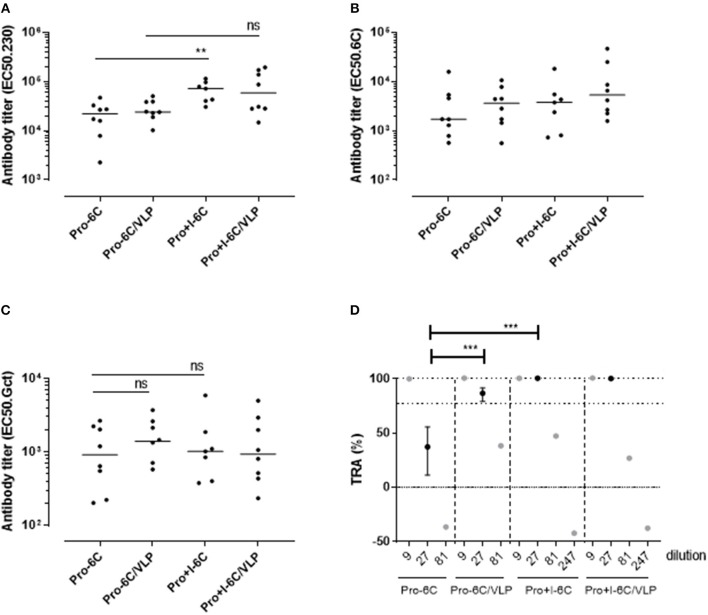
VLP-delivery of Pro-6C and Pro+I-6C. Groups of mice (n = 8) were immunized with soluble Pro-6C and Pro+I-6C or bound to AP205. Day 56 serum was tested for antibody reactivity on ELISA plates coated with (A)
Pfs230 Pro+I,II,III (B), Pfs48/45-6C or (C) gametocyte extract. Antibody titers (dots represents individual mice) are expressed as EC50 values. Horizontal lines represent median values. The asterisks represent statistical significance determined by Mann-Whitney test (**p < 0.01, ns not significant). (D) Functional activities of serial diluted sera were assessed in the SMFA. Transmission reducing activity (TRA) is the reduction of oocyst load compared to a serum control. All samples are tested in the presence of active complement. Data points are best estimates of two independent SMFA experiments and error bars represent 95% confidence intervals. Note that 1/81 and 1/247 samples were tested in SMFA only once and therefore no confidence intervals are given. Comparison between samples was done using General Linear Mixed Regression analysis (***p < 0.005, ns, not significant).